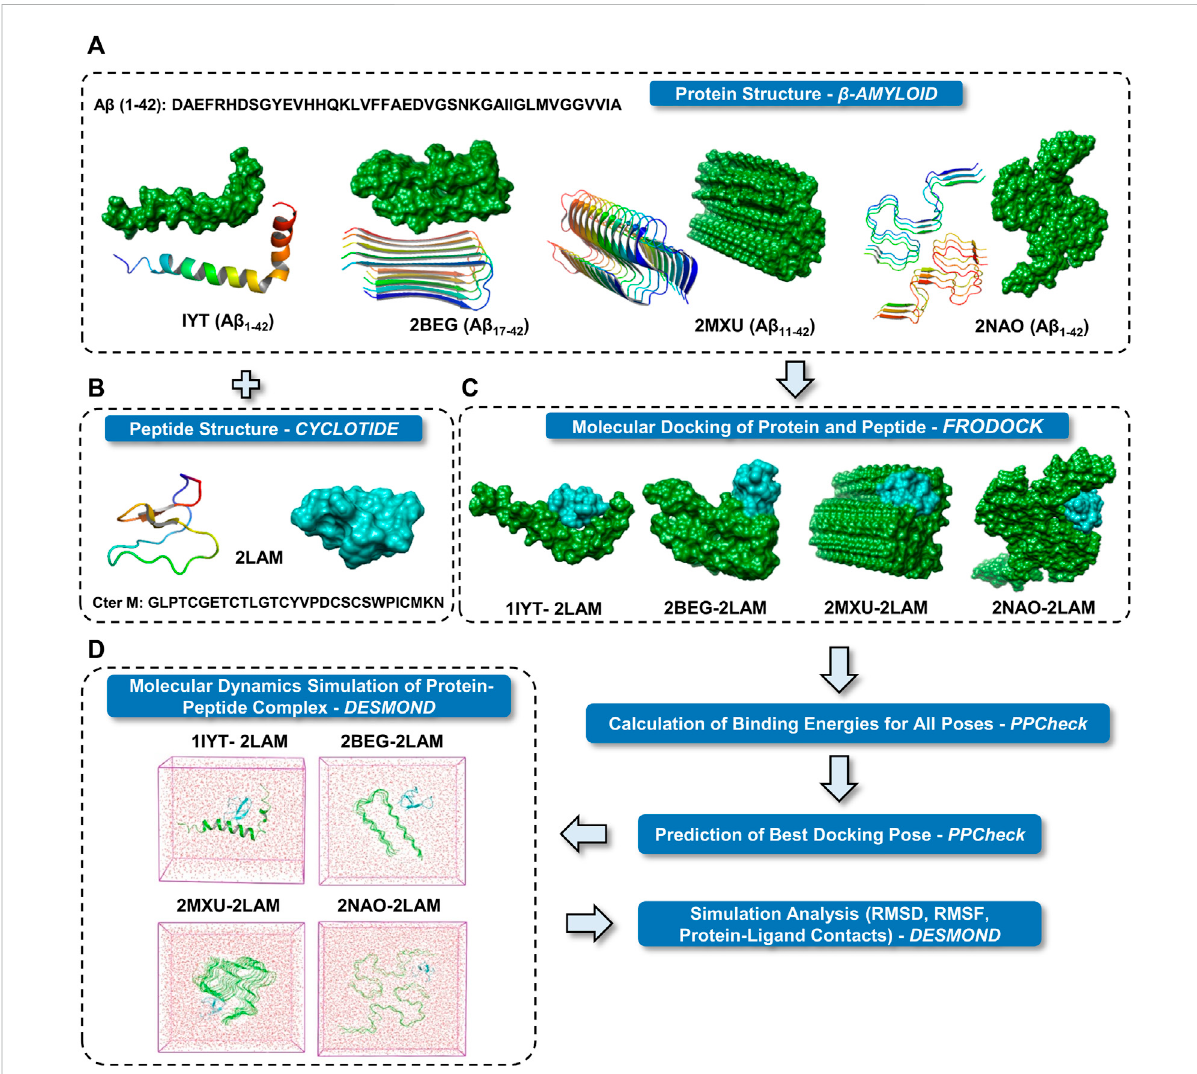
FIGURE 1 Schematic representation of the research protocol used in the present study. (A) Cartoon and surface representations of the four different A β structures. (B) Cartoon and surface representation of cyclotide Cter M structure. (C) Surface representations of the best binding mode of the four docked complexes of A β and cyclotides. Color scheme used for surface representation: green — A β and cyan — cyclotide. (D) The protein complexes are minimized and placed in a box of water. The systems were then set up for MD